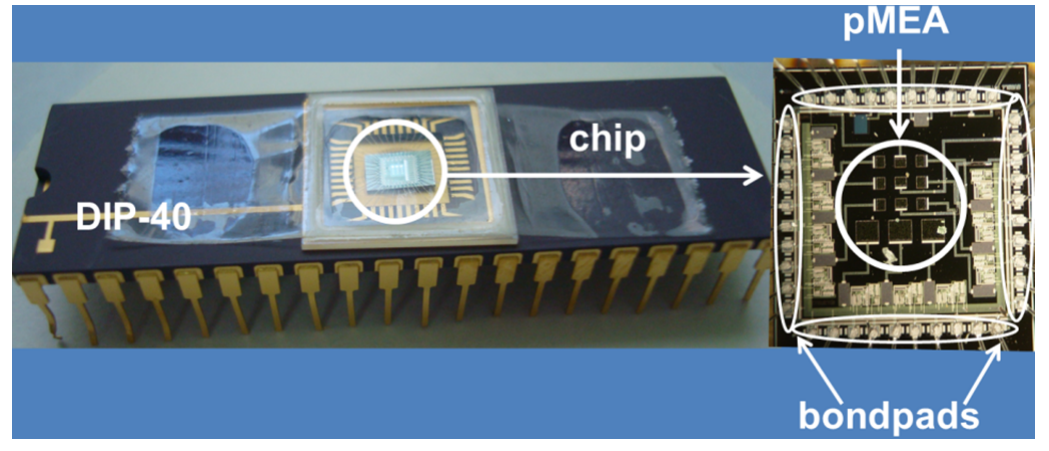
Figure 11. Microphotograph of chip packaged in a